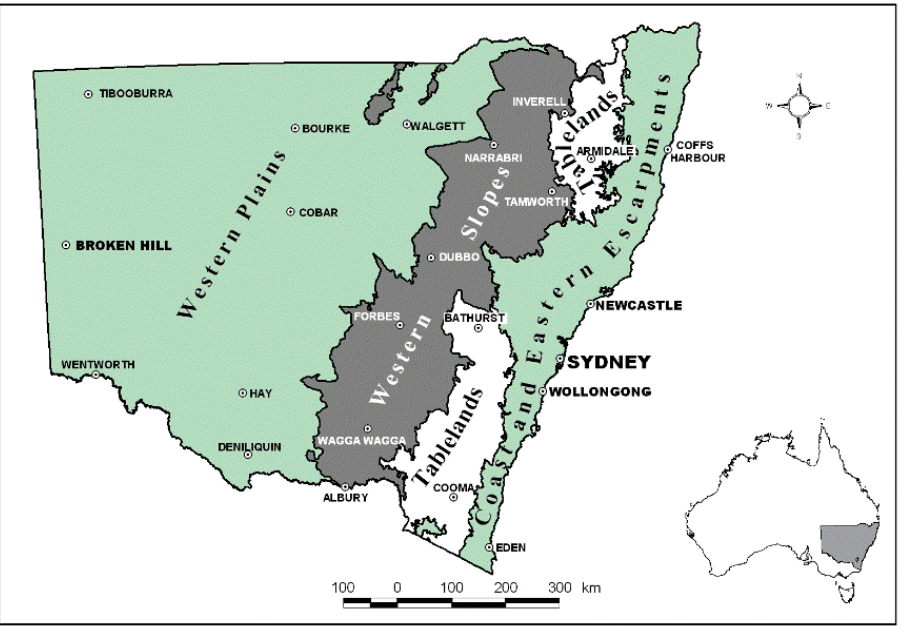
Figure 1. The Western Slopes and Western Plains comprising inland NSW, source